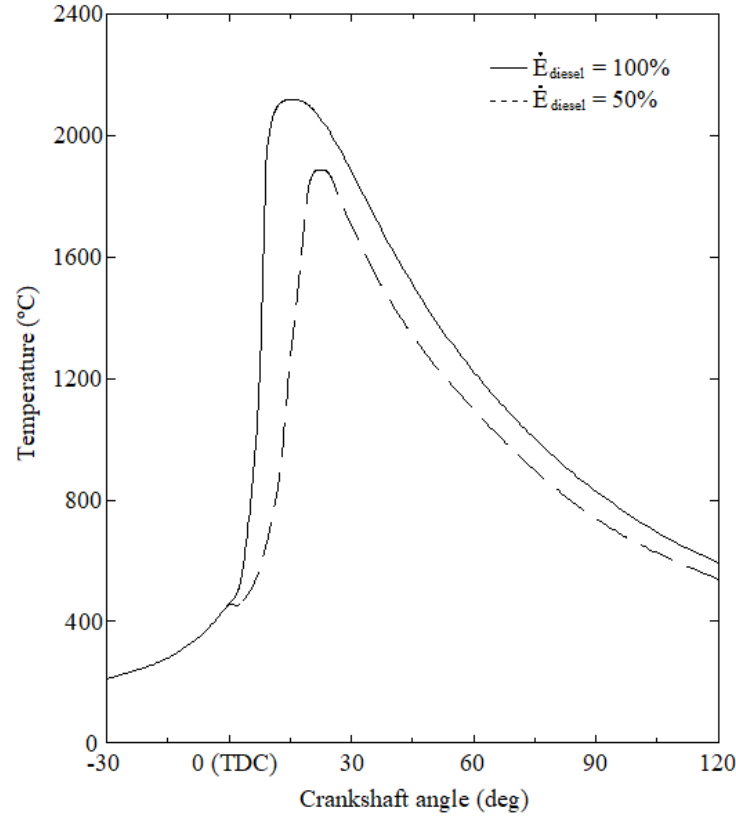
Figure 5. In-cylinder average temperature under 100% and 50% power contribution from diesel fuel. Regarding CO and HC emissions, these are shown in Figures 6 and 7, respectively.